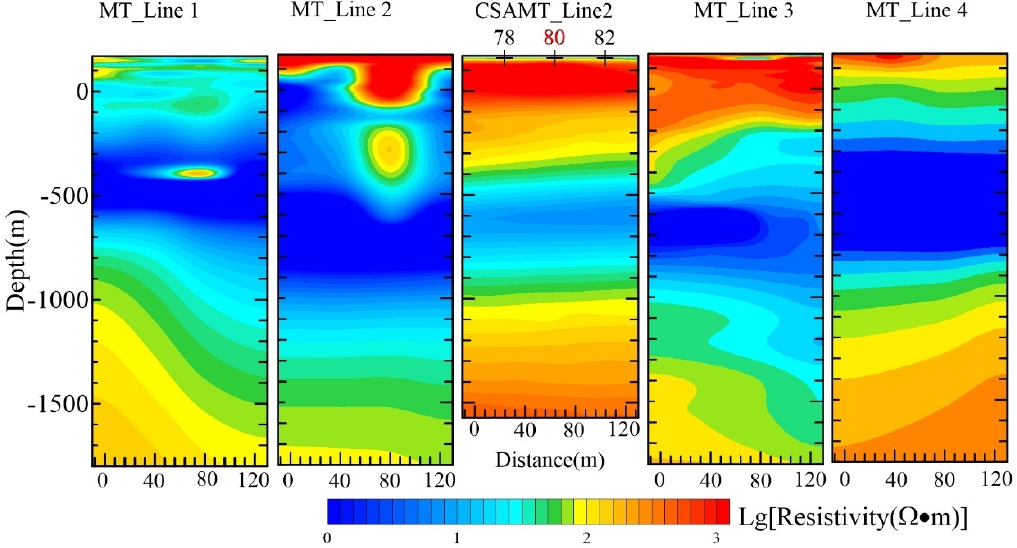
Figure 6. Comparison of small-scale MT inverted section and CSAMT inverted section at designed drilling location. The resistivity of these sections varies with depth in the same way.